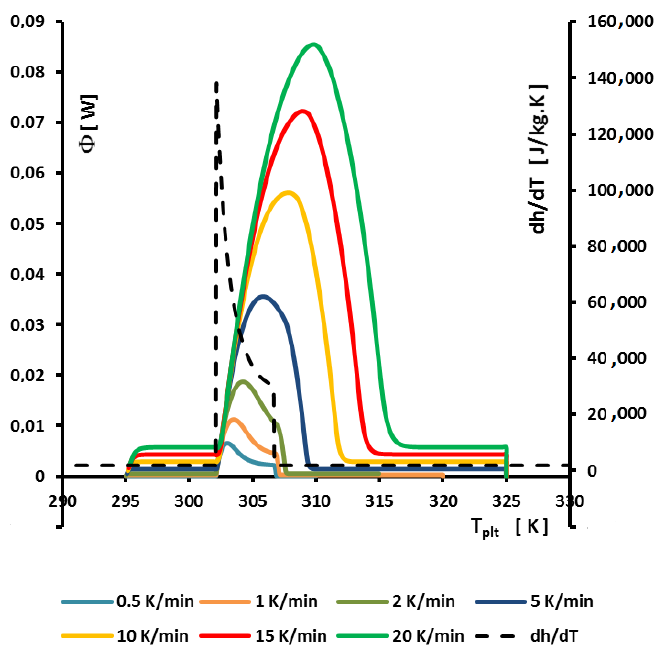
d h for a solution at x 0 = 0.2; from [16]. d T